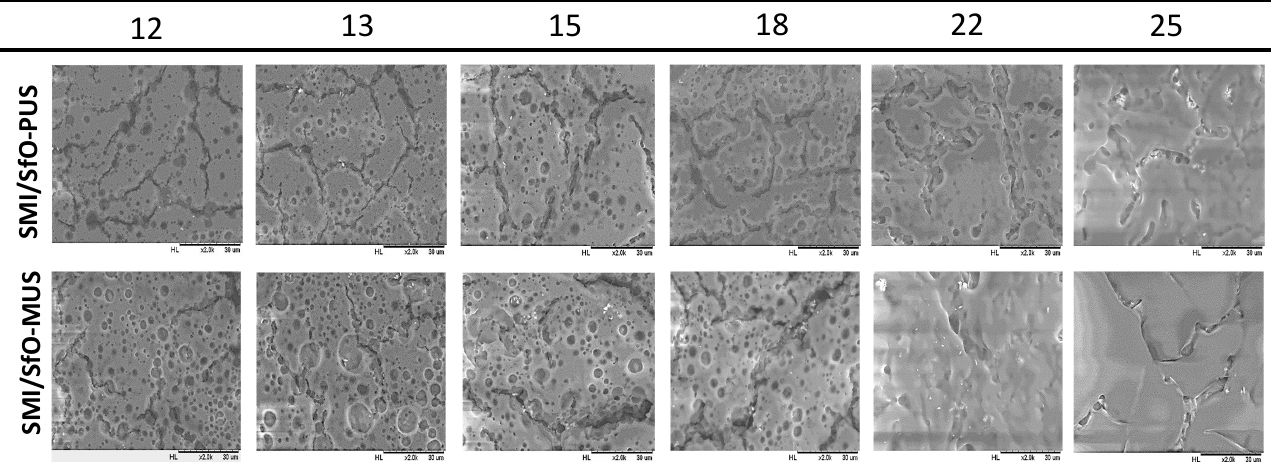
Figure 3. Surface morphology of SMI/SfO-PUS and SMI/SfO-MUS coatings after thermal release of oil at different temperatures (magnification × 2000).